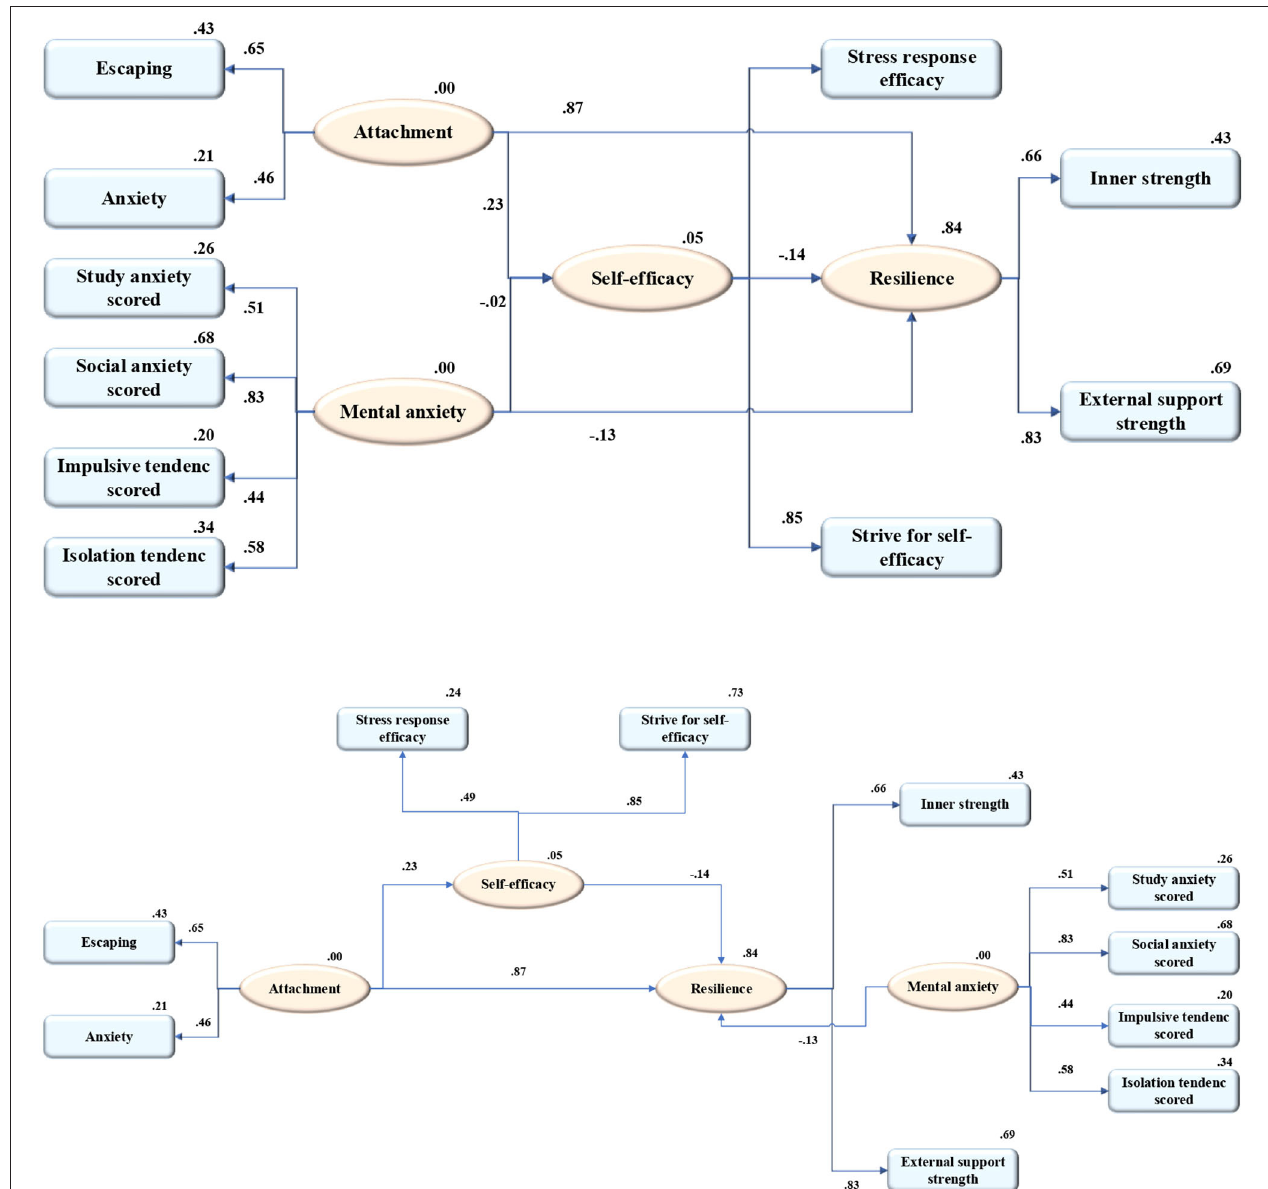
FIGURE 6 | The corrected model of resilience